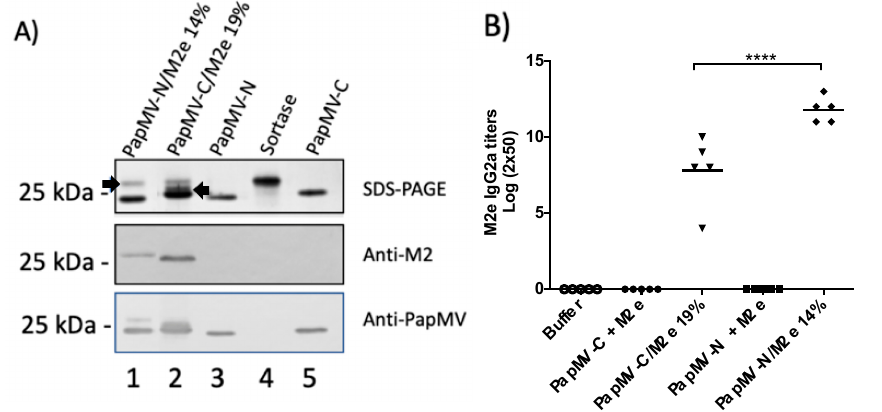
Figure 3. Coupling of the M2e peptide to the PapMV vaccine platforms and assessment of the humoral response directed to M2e in mice. ( A ) The M2e antigen was coupled to the PapMV-N and PapMV-C vaccine platforms using the sortase A (SrtA) enzyme. Coupled bands for both platforms can be visualized on SDS-PAGE slightly over the 25 kDa marker. The arrow pointing to the right indicates the signal of the PapMV-N coupled to the M2e peptide (lane 1), and the arrow pointing to the left indicates the signal of the PapMV-C coupled to the M2e peptide (lane 2). Signals corresponding to PapMV-N CP (lane 3) and PapMV-C CP (lane 5) are also observed. The signal corresponding to SrtA is shown in lane 4. Remaining SrtA after the coupling reaction is seen in lanes 1 and 2. Proteins from the SDS-PAGE were transferred to a membrane to perform Western blotting using anti-M2e (middle panel) or anti- PapMV (lower panel) antibodies. ( B ) Balb/C mice, five per group, were immunized once, intramuscularly (i.m.), with formulation buffer (Buffer), PapMV-C (10 µg) with 1 µg of free peptide M2e, 10 µg PapMV-C/M2e 19%, PapMV-N (10 µg) with 1 µg of free peptide M2e, and 10 µg PapMV-C/M2e 14%. ELISA was performed with serum harvested at day 20 to assess immunoglobulin G (IgG) 2a titers directed to the M2e peptide. **** p > 0.0001.